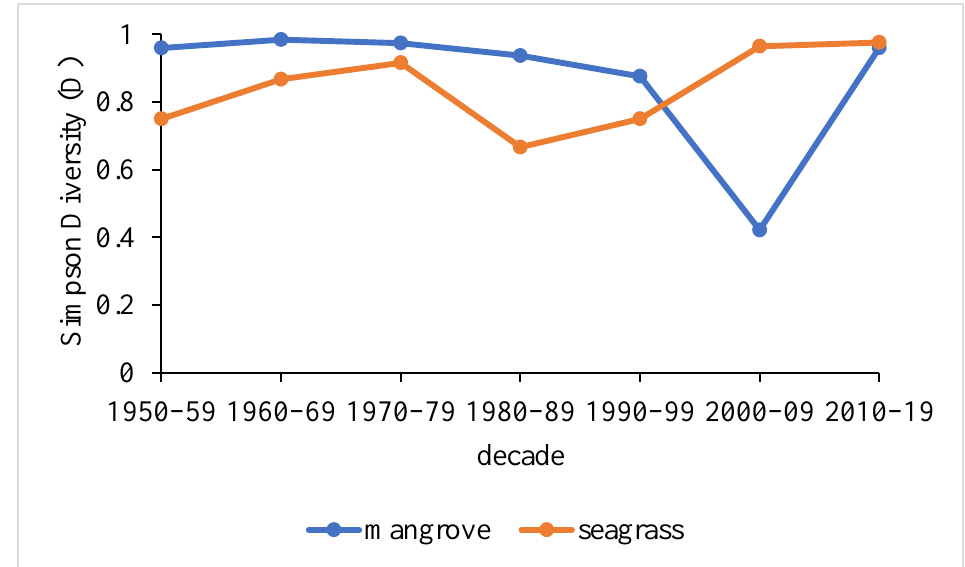
Figure 3 . Marine invertebrate taxonomic diversity (Simpson’s Diversity Index—D) of mangroves and seagrasses in Maputo Bay per decade.